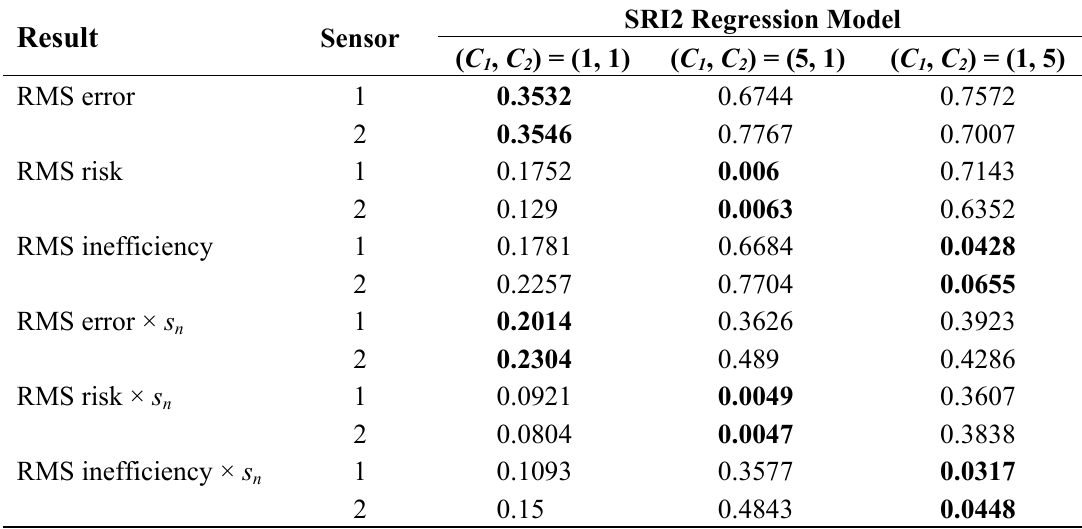
and C values using 1,000 test 1 2